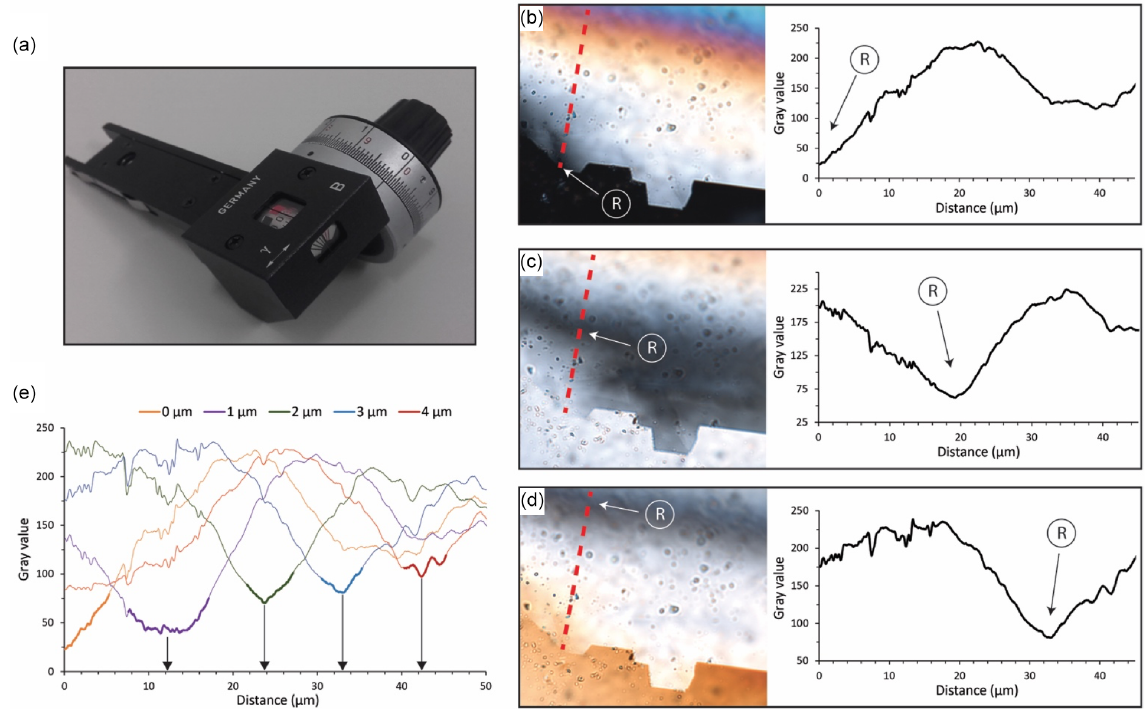
Figure 1. Technique for quantifying wedge thickness. (a) Tilting compensator B 0-5 Lambda. (b–d) Schematic succession of images showing the migration of the compensation point under along the calcite wedge (OVD-W1) linearly polarized light with successive rotations of the compensator. The minimum grayscale value in each image corresponds to the full compensation of interference colors at that point, and is designated by an “R” in each image. The blue tone produced by partial compensation of interference colors leads to second local minima in grayscale on either side of the full compensation. (e) Full grayscale profiles along the wedge with compensator rotation equivalent to four selected thicknesses of calcite. Arrows show the distance of maximum compensation for each tilting compensator rotation, and denote the distance on the OVD-W1 wedge corresponding to that thickness. Data in (e) were collected on a Zeiss Axio Scope and were used for quantitative calibration of the wedge. Light intensity was saturated at a calcite thickness of